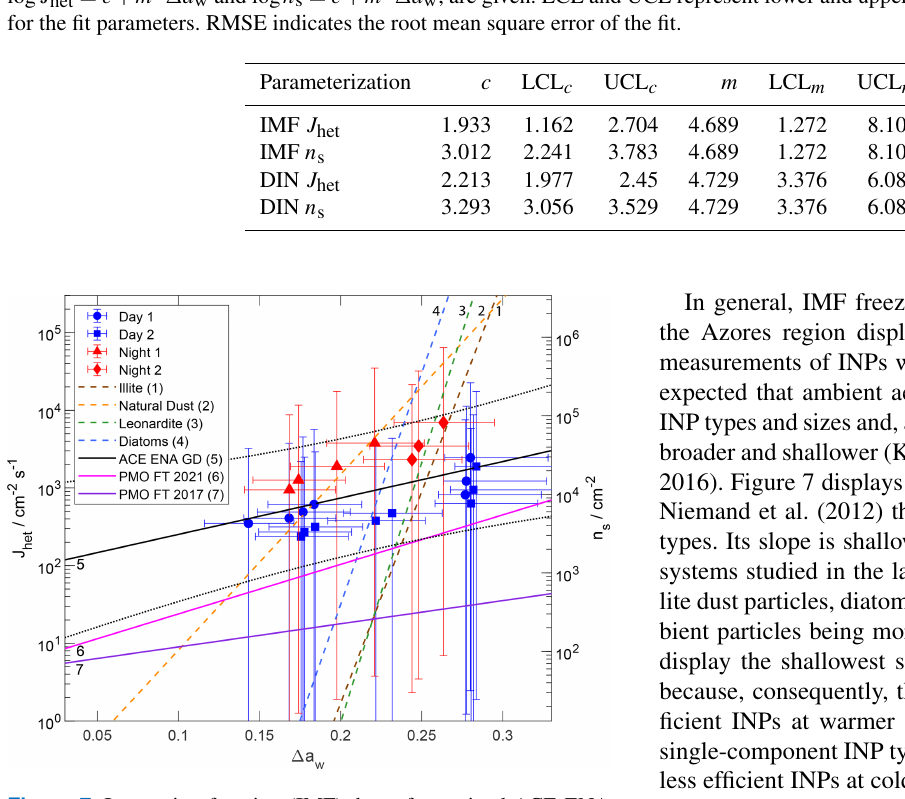
Figure 7. Immersion freezing (IMF) data of examined ACE-ENA particle samples (solid symbols) and of previous studies (colored lines) as given in the legend. Heterogeneous ice nucleation rate co- efficients ( J het ) and ice nucleation active site (INAS) density ( n s ) are presented as a function of the water activity criterion (cid:49)a w . Er- ror bars include uncertainties in temperature, humidity, and surface area. Solid and dotted black lines represent a linear regression fit and associated fit uncertainties “ACE-ENA GD” to the data. Pur- ple and magenta solid lines indicating “PMO FT 2017” and “PMO FT 2021”, respectively, represent IMF parameterizations of parti- cles collected at the Pico Mountain Observatory (PMO) under free tropospheric (FT) conditions in the Azores on a neighboring island (China et al., 2017; Lata et al., 2021). Please note that only J het was reported for PMO FT 2021 (Lata et al.,